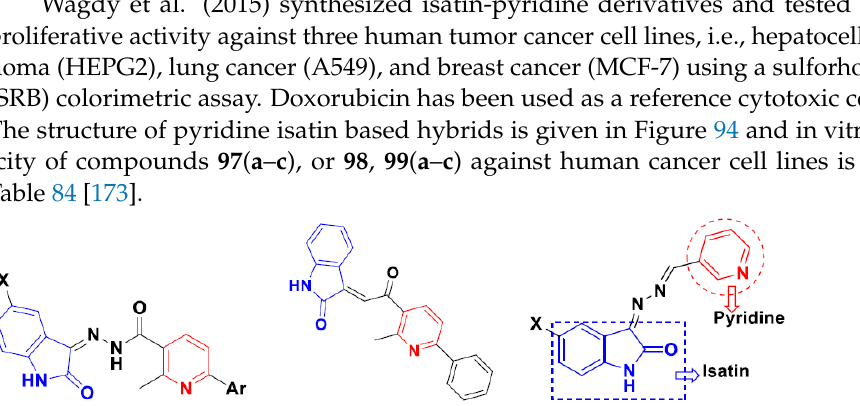
Figure 93. Structure of isatin-dihydropyrazole derivatives ( 96 ).